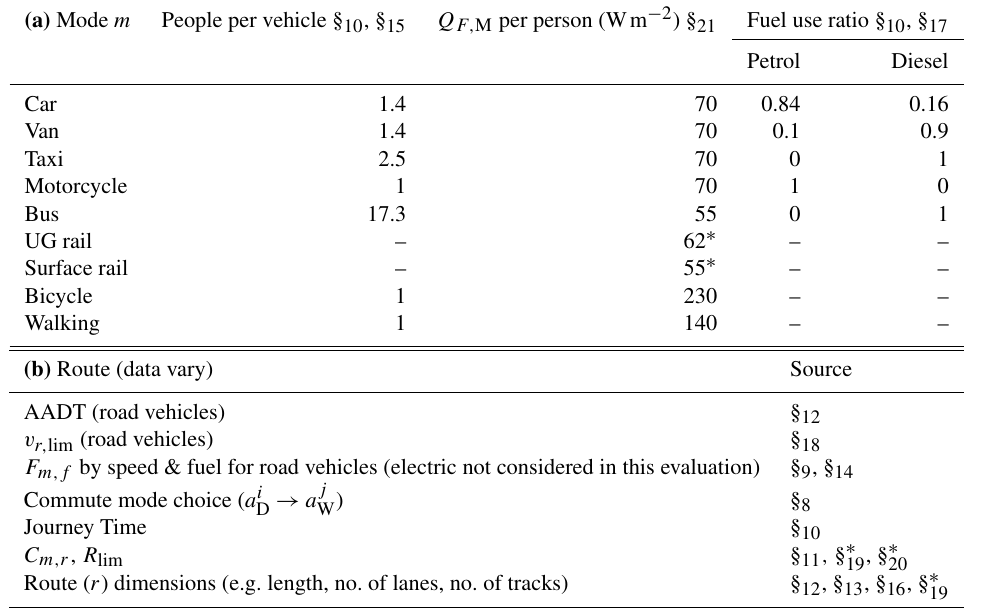
Route ( r ) dimensions (e.g. length, no. of lanes, no. of tracks)